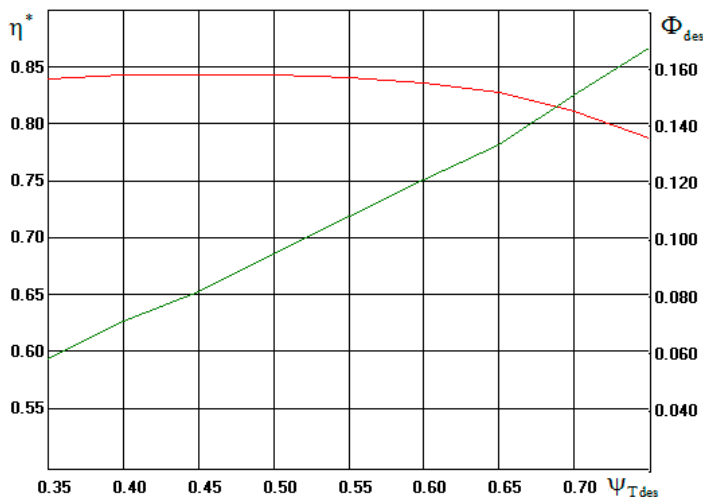
ffi ciency and flow coe ffi cient versus